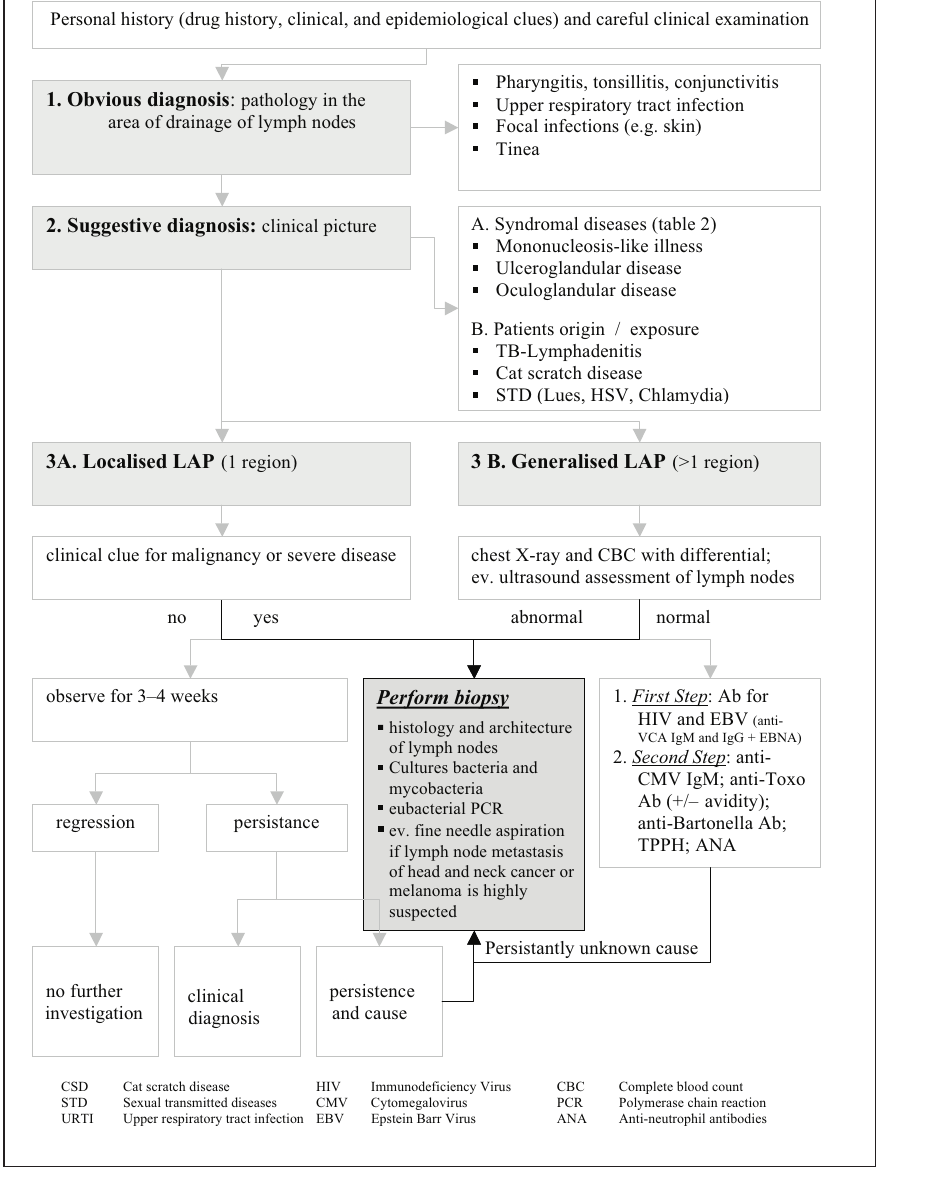
Figure 1 Diagnostic algorithm for the evaluation of patients with unexplained lymphadenopathy (adapted from [5] and